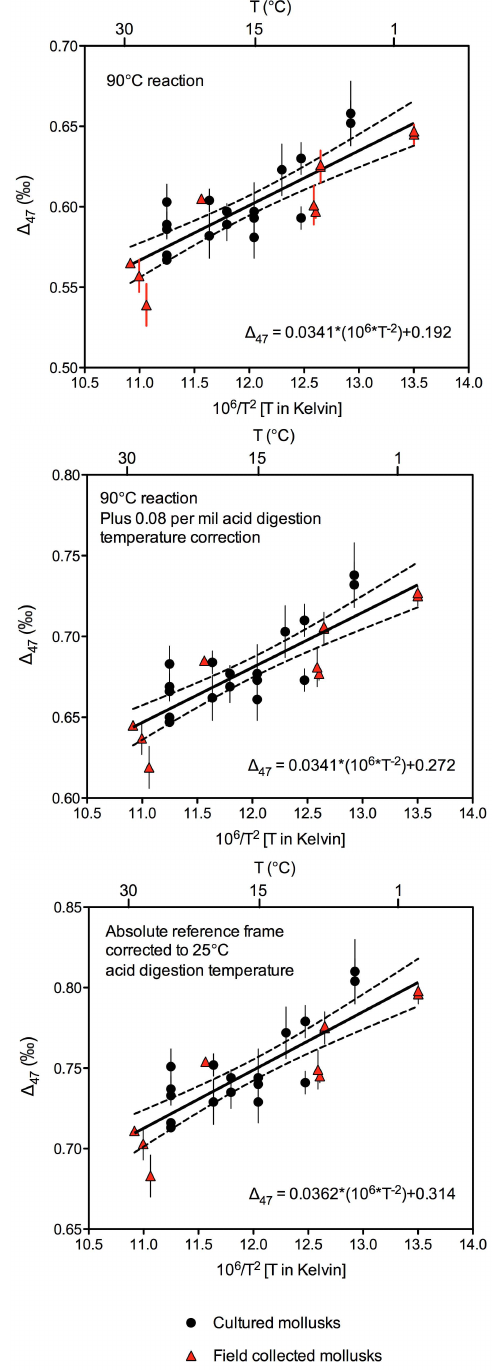
Fig. 2. Bivalve 1 47 calibration data. The top panel shows a linear regression with 95% confidence intervals through 1 47 measurements made on both cultured (circles) and field collected (triangles) mollusks grown at different temperatures. Shells were re- acted with phosphoric acid heated to 90 ◦ C to produce analyte CO 2 . These data are rel- ative to the stochastic distribution as described previously (Huntington et al., 2009) and do not have the empirically derived acid digestion correction of 0.08‰ added (Passey et al., 2010), which is used to compare data to that derived from a 25 ◦ C acid digestion reaction. The middle panel is the data with this correction. The bottom panel is bivalve calibration data with the acid digestion correction, then converted into the absolute ref- erence frame (Dennis et al., 2011) using a secondary transfer function. Equations for the relationship between measured 1 47 and bivalve growth temperature are given in each